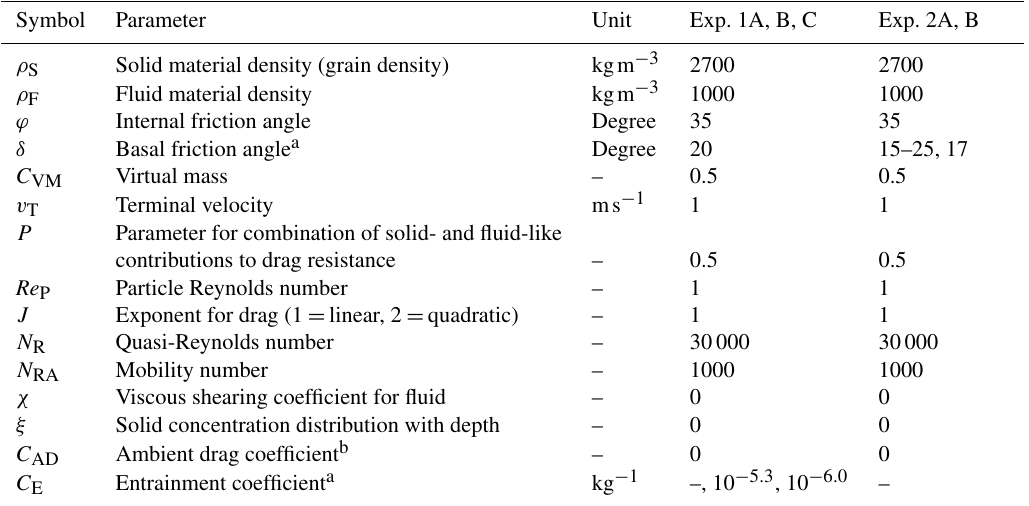
Table 2. Flow parameters and entrainment coefficient required with the enhanced version of the Pudasaini (2012) two-phase flow model. Exp. 1 and 2 refer to the values used for the computational experiments introduced in Sect.